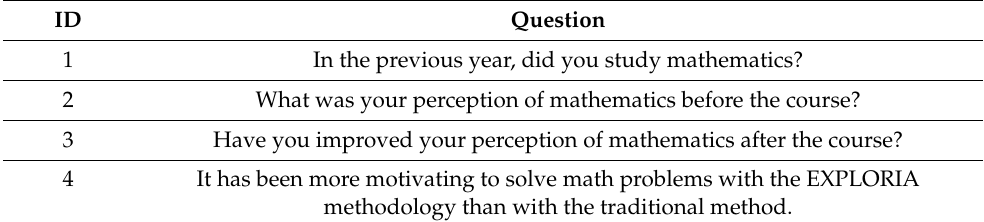
Table 5. Questions asked in the questionnaire for the